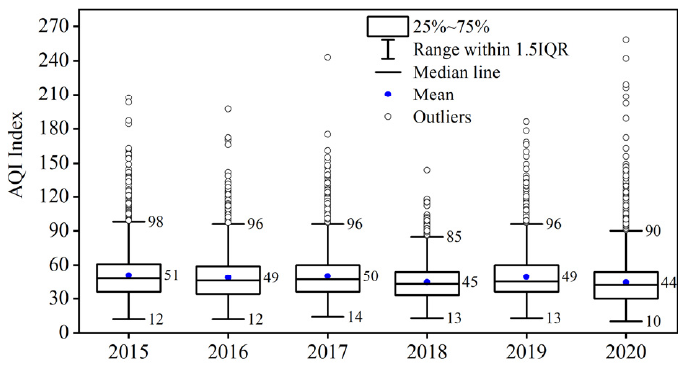
Figure 3. The characteristics of AQI in Yunnan from 2015 to 2020.